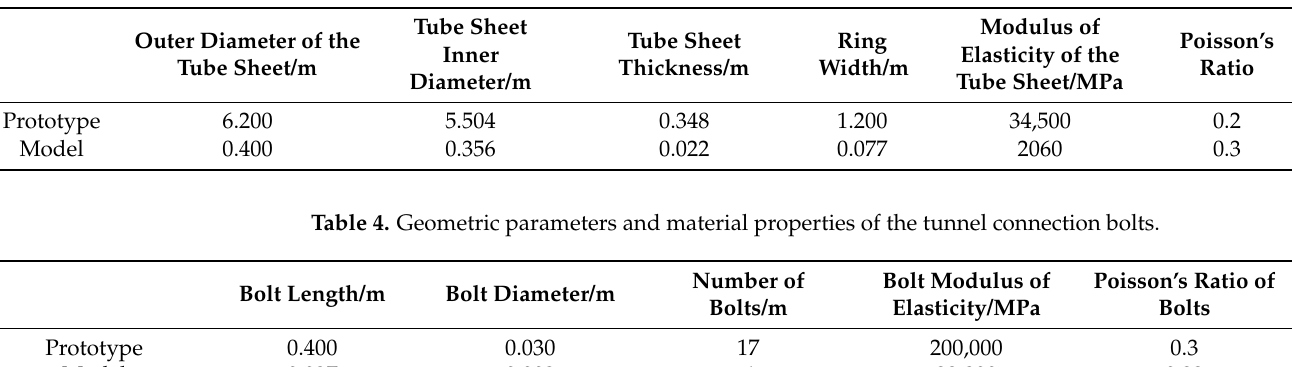
Table 4. Geometric parameters and material properties of the tunnel connection bolts.